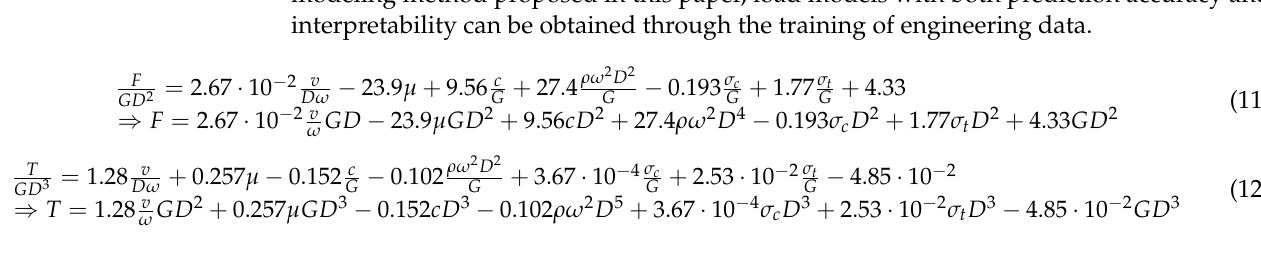
Table 4. Comparison of tunneling total load models under different modeling methods. Total Thrust Total